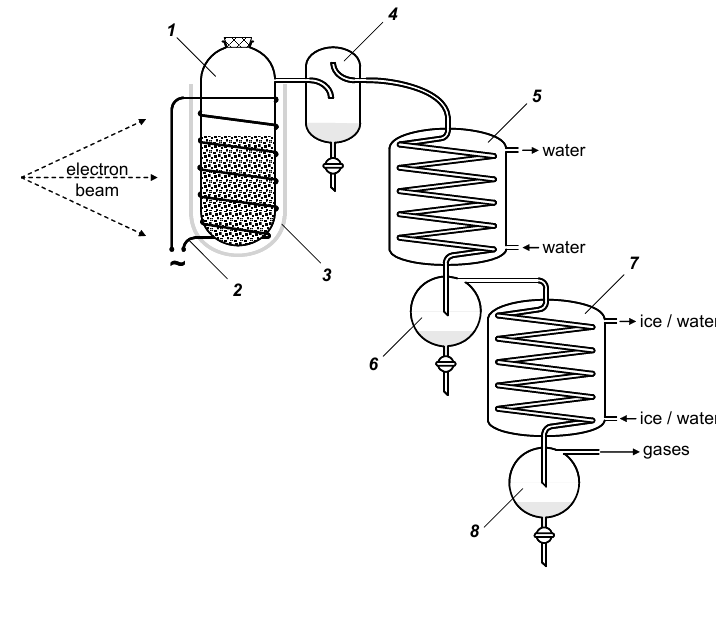
Figure 16. Schematic of the laboratory